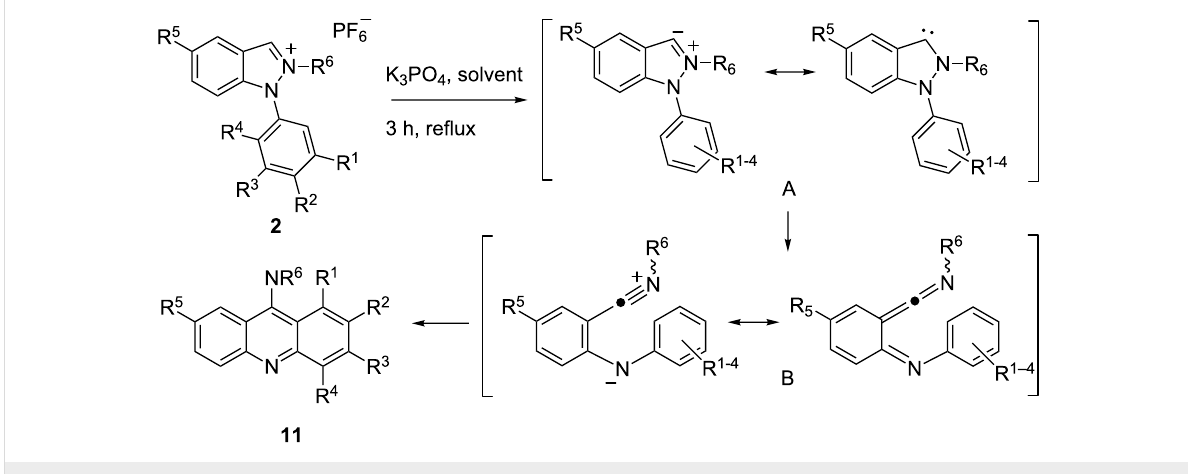
Scheme 3: Syntheses of acridines from indazol-3-ylidenes.